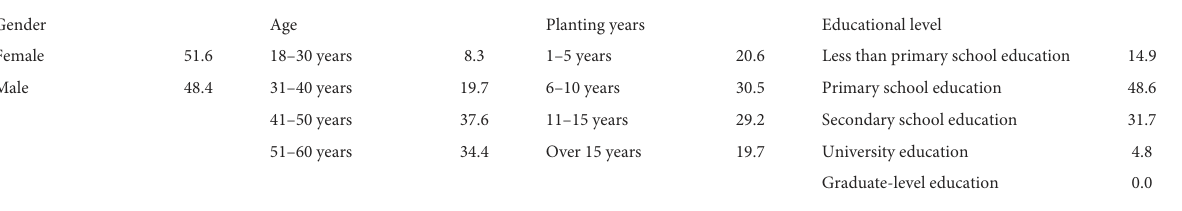
TABLE 2 Demographics of the sample ( n =